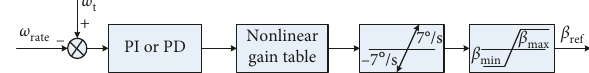
Figure 12: Pitch control based on nonlinear PI or PD controller.